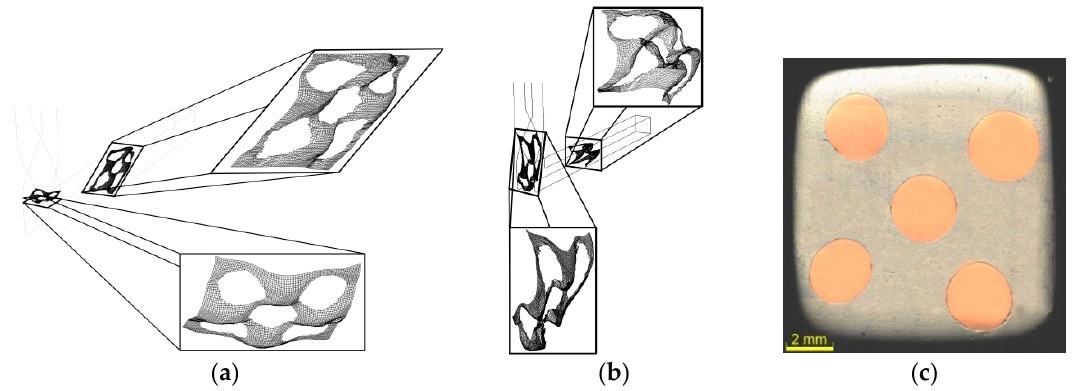
Figure 6. Material plastic flow of Al/Cu composite during: first pass ( a ), second pass ( b ); optical microscopy image of cross-sectional cut through billet extruded via two passes ( c ).